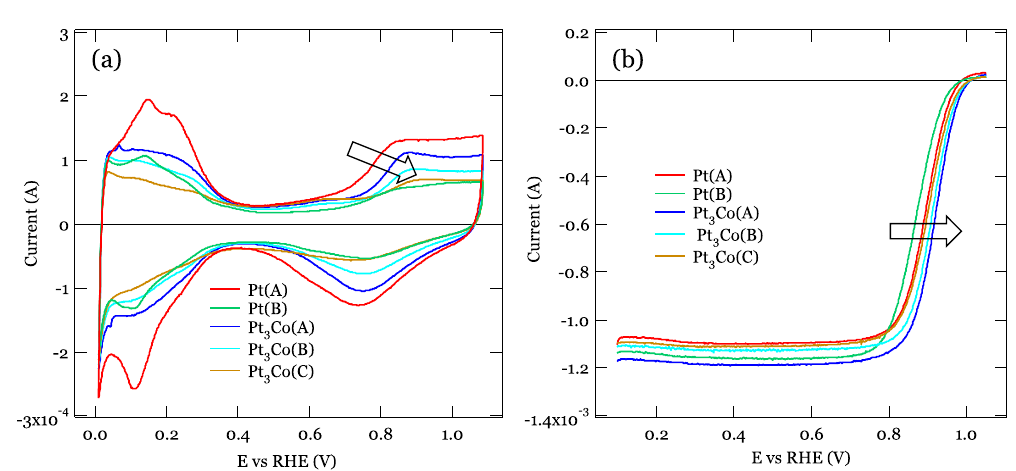
Figure 2. The electrochemical performance measurements. ( a ) Cyclic voltammetry of samples in this work. ( b ) The oxygen reduction curve by linear sweep voltammetry. The arrows marked the trends in cyclic voltammetry and oxygen reduction curve changes against different